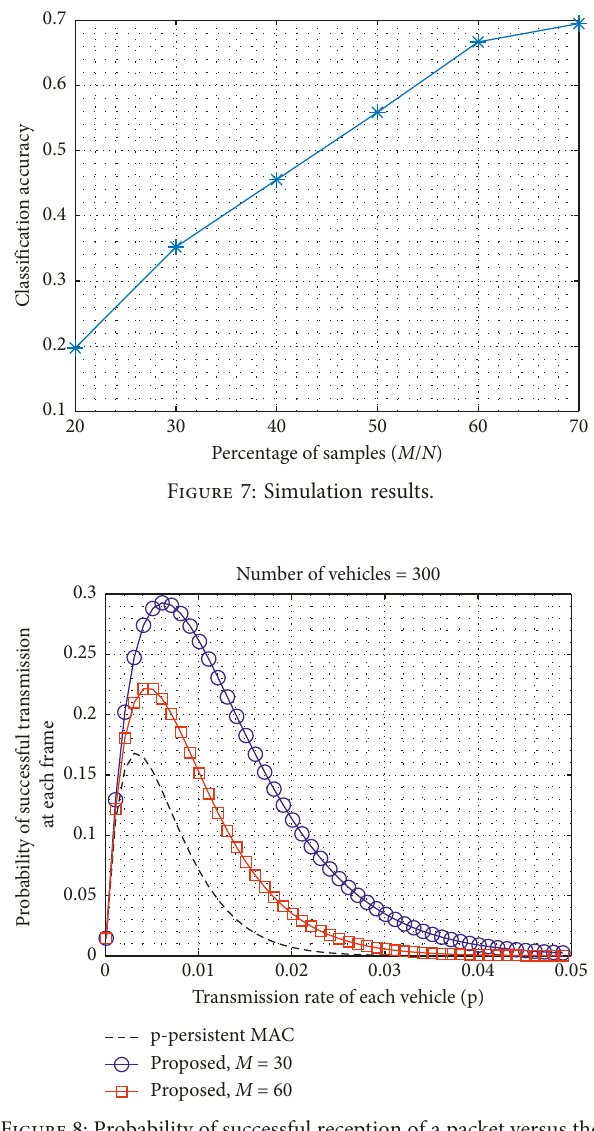
Figure 8: Probability of successful reception of a packet versus the transmission load for different values of M while V is fixed.